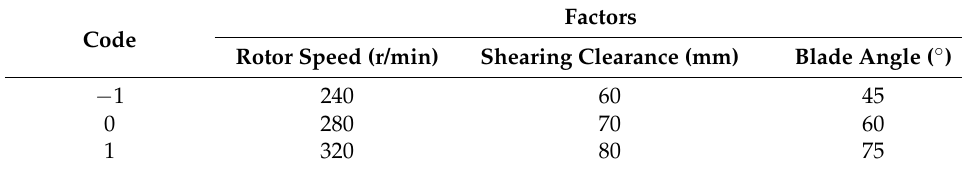
Table 2. Test factor codes.